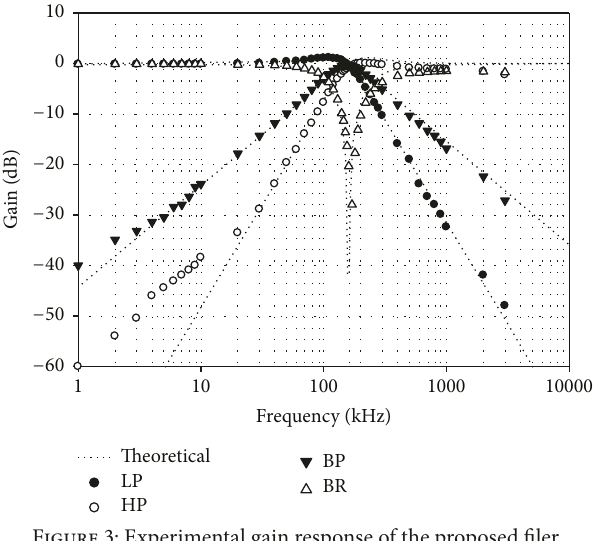
Figure 3: Experimental gain response of the proposed filer.